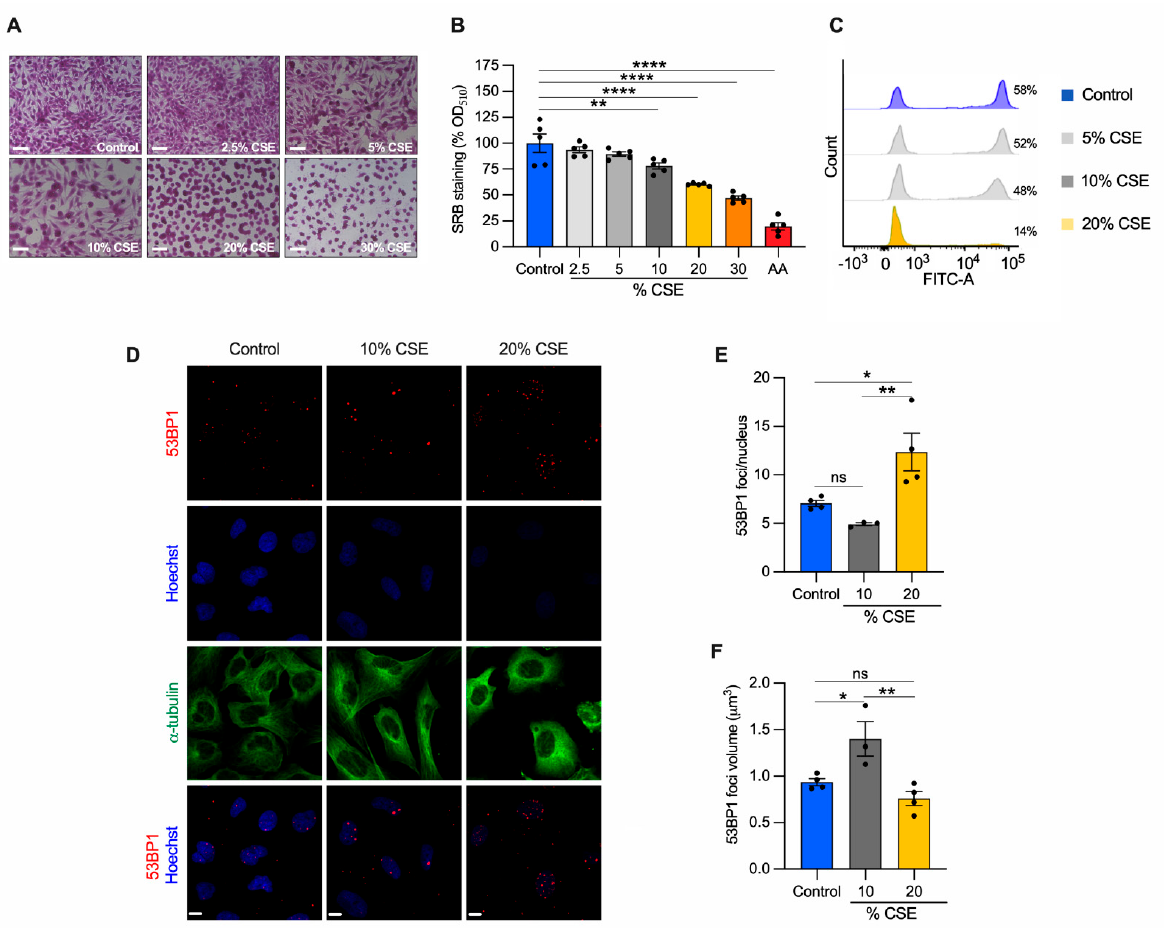
Figure 2. CSE inhibits cell proliferation, promotes nDNA damage, and cell death. BEAS-2B cells exposed to the indicated CSE dose (%) for 24 h were ( A ) stained with sulforhodamine B (SRB) and ( B ) quantified by measuring the absorbance at 510 nm and normalized to unexposed cells (control, shown as 100%). Antimycin A (AA) was used as a positive control for cell toxicity. Scale bar = 100 µ m; ( C ) representative analysis of flow cytometry showing the number of cells (%) engaged in de novo DNA synthesis by EdU incorporation ( n = 2); ( D ) representative maximum projections of confocal image stacks of 53BP1 (red), the nucleus (Hoechst, blue), and the cytoskeleton ( α -tubulin, green); ( E ) the number of 53BP1 foci per nucleus, and ( F ) their volume in control, 10%, and 20% CSE-treated cells. Scale bar = 10 μ m. (B, E, and F) Data are reported as mean ± SEM of independent experiments indicated as circles ( n ≥ 3). CSE, cigarette smoke extract; control, CSE ‐ unexposed cells. ns, no statistical significance; * p < 0.05, ** p < 0.01, **** p < 0.0001 were determined by one ‐ way ANOVA with multiple comparisons using (B) Dunnett’s or (E,F) Tukey’s post hoc tests.